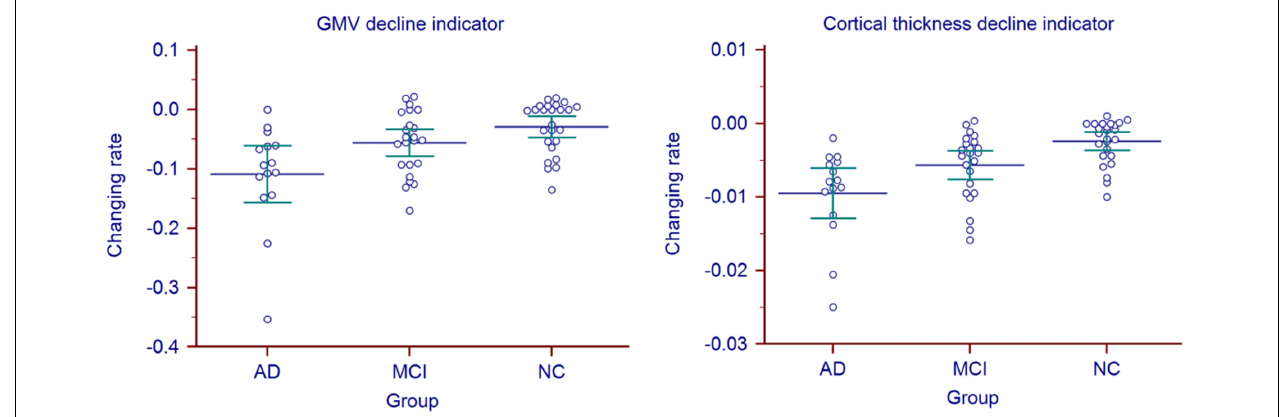
FIGURE 3 | Atrophy indicators’ longitudinal changing rate of all the individuals in AD, MCI, and NC group.